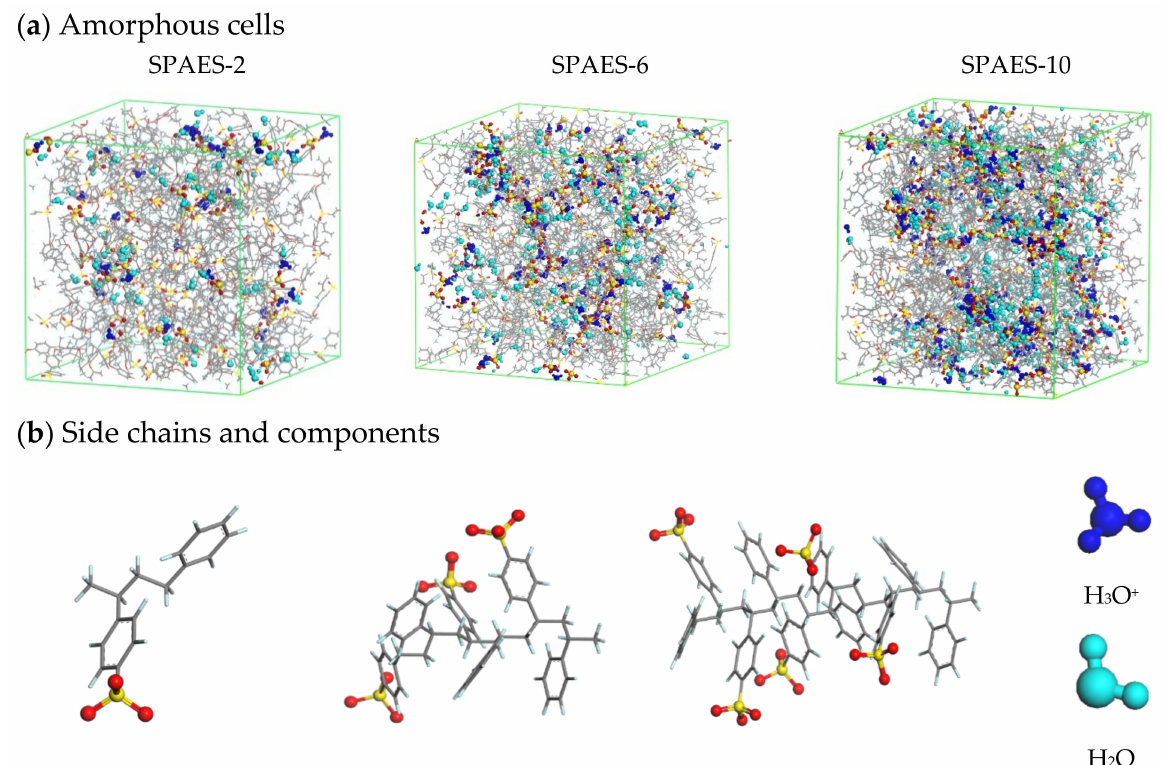
Figure 2. Snapshots of ( a ) the equilibrated amorphous cells and ( b ) components of the polymer side chains, as well as water molecules and hydronium ions. Color scheme in the polymer chains: carbon in gray, hydrogen in light cyan, oxygen in red and sulfur in